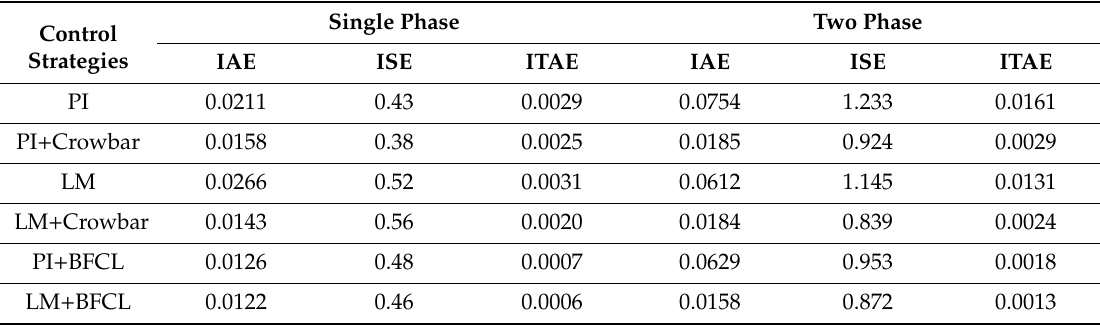
Table 1. Performance index analysis of the Designed Control Scheme for Vdc.